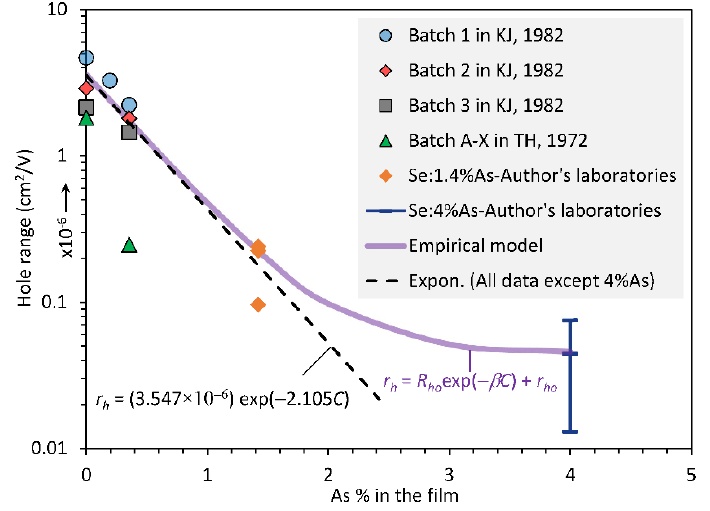
Figure 4. A semilogarithmic plot of the dependence of the hole range r h on the As content C in the film. The initial hole lifetime has batch-to-batch variations. Data were extracted, reanalyzed, converted to the average As content in the film, and then replotted. KJ, 1982, and TH, 1972, are [9,10], respectively. Note: R ho = 3.547 × 10 − 6 cm 2 V − 1 is a preexponential constant, β = 2.105 percent − 1 .